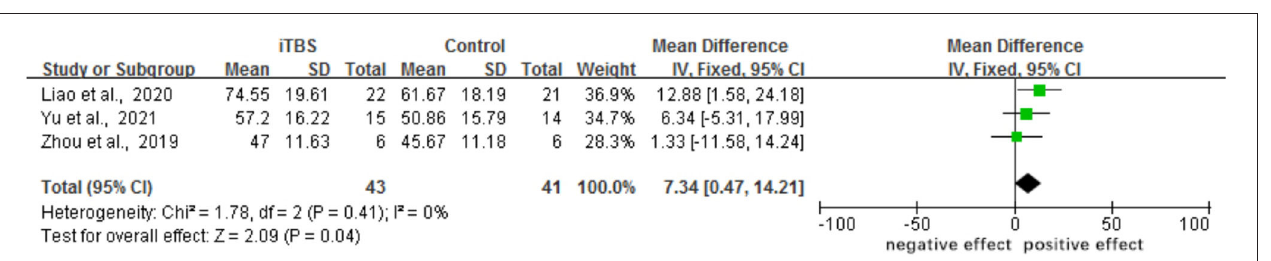
FIGURE 6 | Forest plots of the pooled results on daily